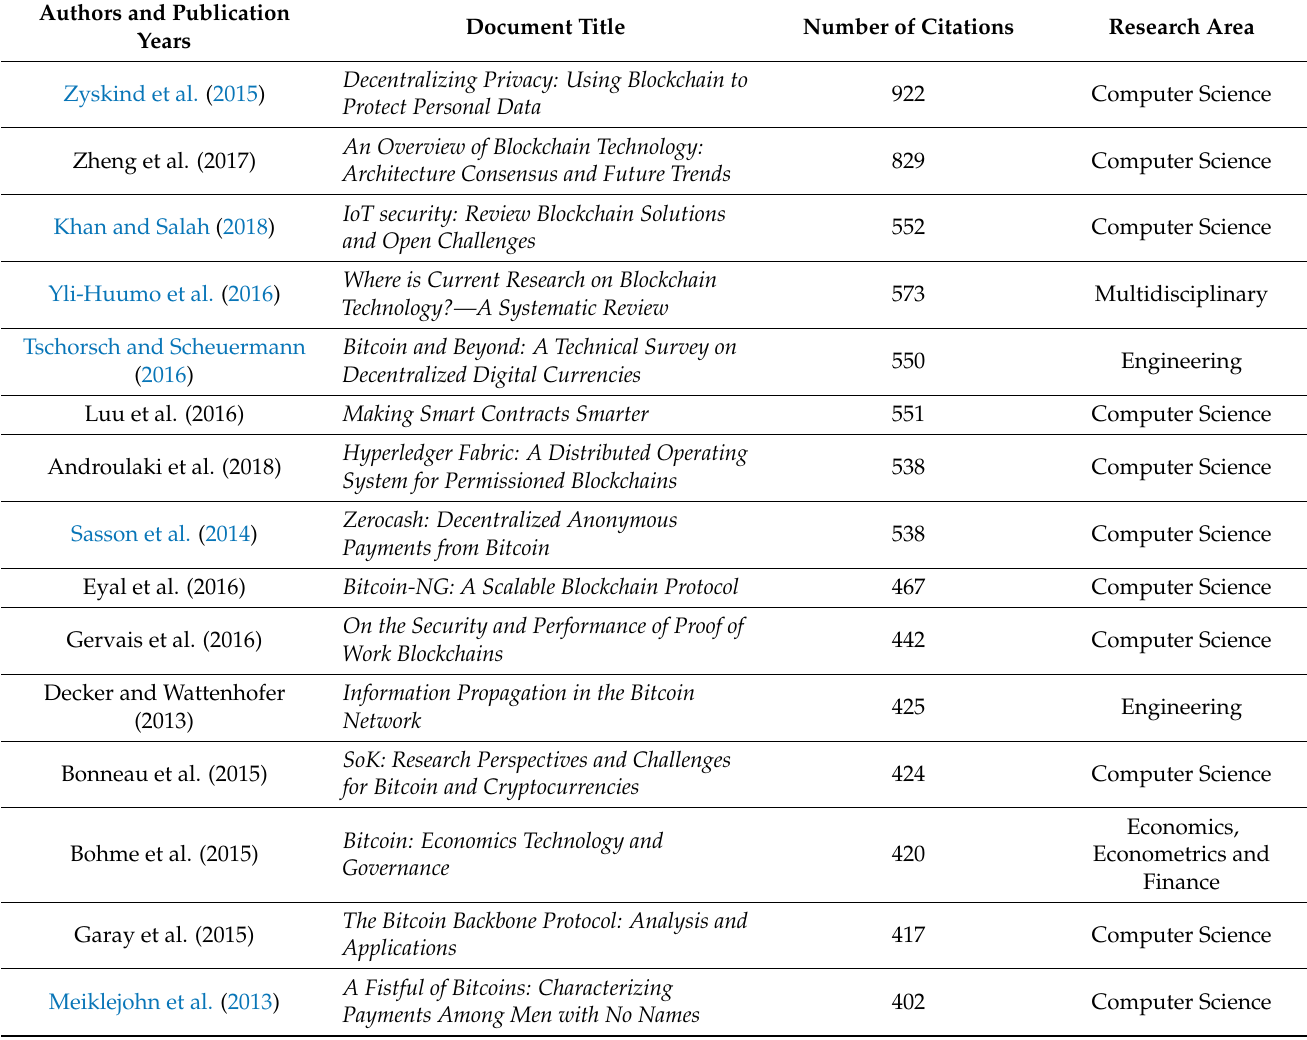
Table 6. Highly cited articles (in descending